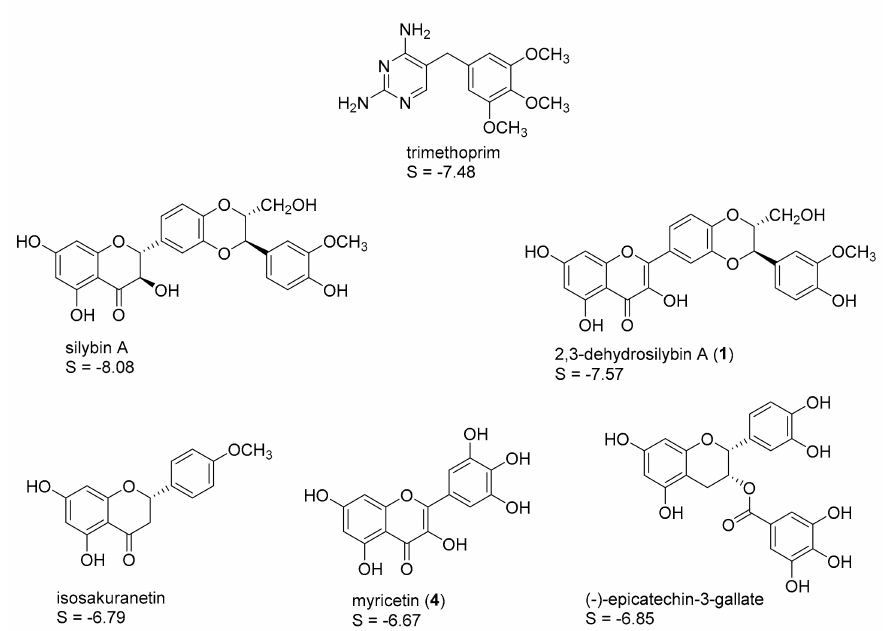
Figure 2. Best five hits from the virtual screening based on the trimethoprim pharmacophore ( Lm PTR1 PDB-ID “2BFM”); S-scores of the induced-fit docking simulations are given in kcal/mol. A “self-docking” computation of the co-crystallized inhibitor trimethoprim was performed accordingly.